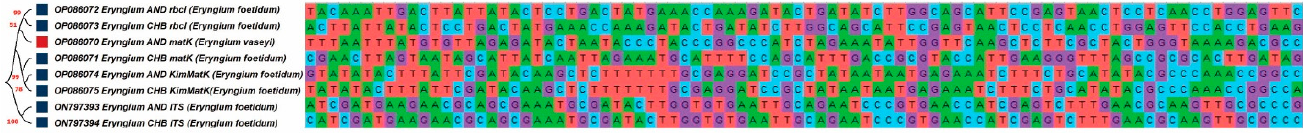
Figure 2. Multiple sequence alignment of matK , Kim matK , rbcL , and ITS2 barcode primers and their phylogenetic relationship among two Eryngium genotypes.